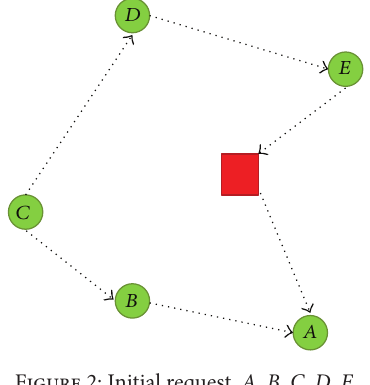
Figure 2: Initial request, A , B , C , D , E .